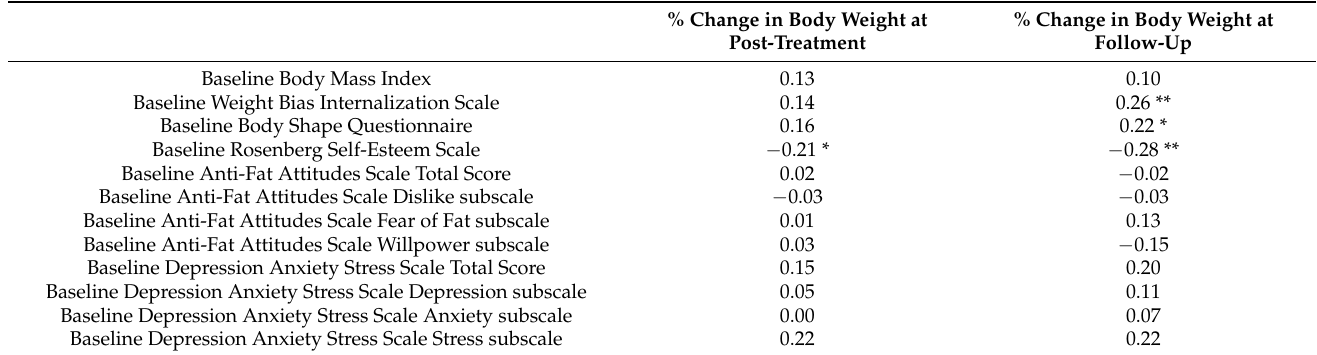
weight at post ‐ treatment and follow ‐ up for participants reporting low baseline Weight Bias Inter ‐ nalization Scale scores and those reporting high baseline Weight Bias Internalization Scale scores. Table 2. Pearson product ‐ moment correlations among percent change in body weight and baseline internalized weight bias and psychological functioning.